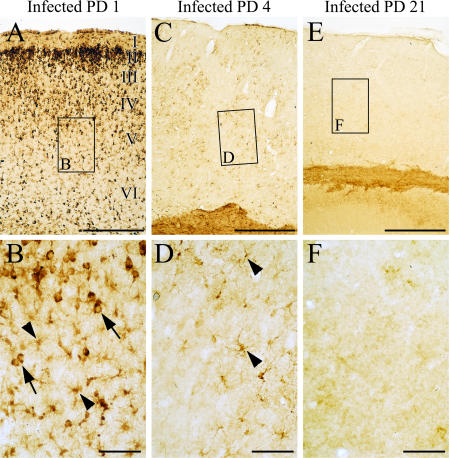
The Cellular Targets of LCMV within the Cerebral Cortex Depend on Host AgeShown are 50-μm-thick sections through the cerebral cortex of rats infected on PD 1 (A), PD 4 (C), or PD 21 (E). In each case, the animals were sacrificed 25 d post-inoculation, and the brain sections were immunohistochemically stained for LCMV antigens.Inoculation on PD 1 leads to infection of cerebral cortical neurons (arrows) and astrocytes (arrowheads). Note that a greater proportion of neurons are infected in superficial cortical layers than in deep cortical layers.Inoculation on PD 4 leads to infection of astrocytes alone (arrowheads). Whereas countless neurons were infectable 3 d earlier, virtually no neurons are infectable by PD4.Inoculation on PD 21 leads to infection of neither neurons nor astrocytes.